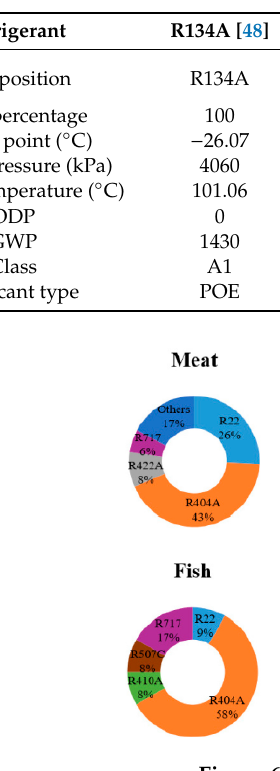
Table 3. Properties of R134A, R450A, R456A, R513A and R515A.